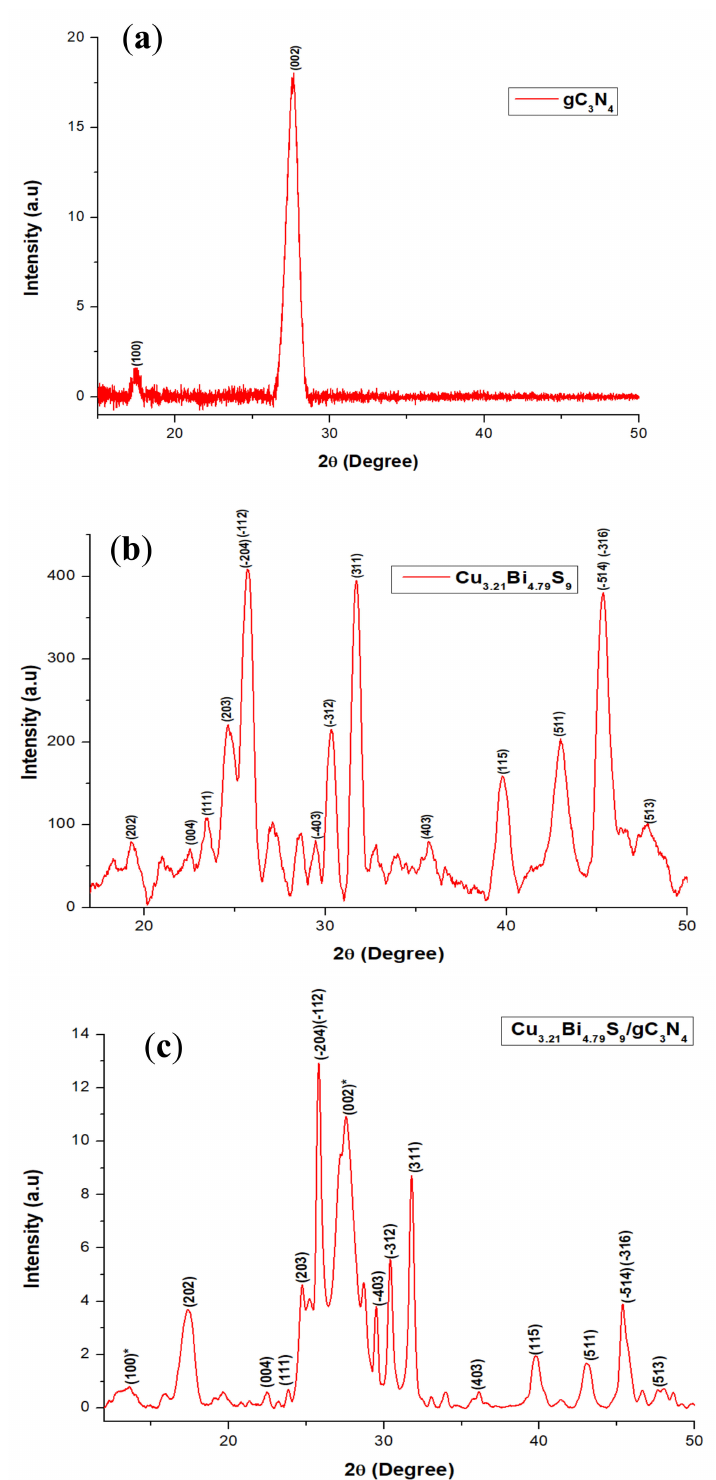
Figure 1. XRDpatternof( a )graphiticcarbonnitride(gC 3 N 4 ), ( b )copperbismuthsulphide(Cu 3.21 Bi 4.79 S 9 ), and ( c ) Cu 3.21 Bi 4.79 S 9 /gC 3 N 4 . The peaks of graphitic carbon nitride are asterisked